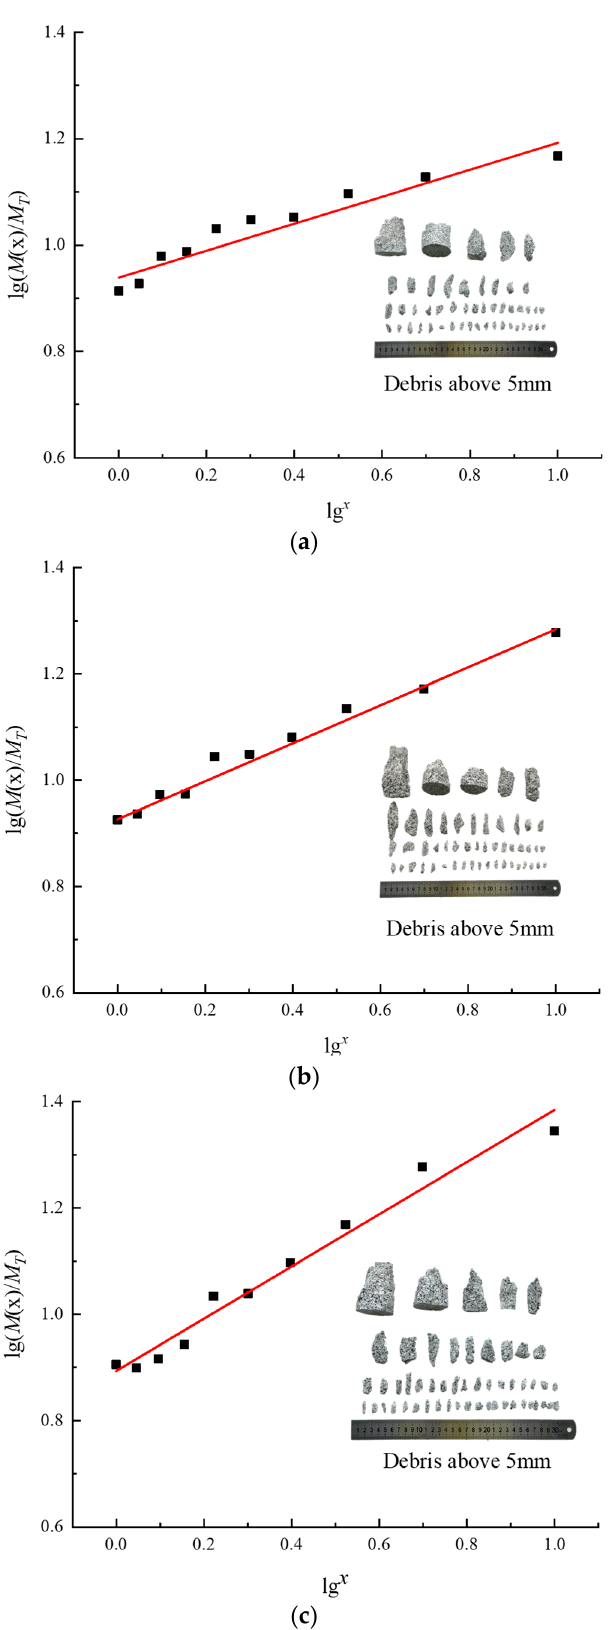
Figure 15. The log( M ( x )/ M T )–logx lines of rocks under 80% of the UCS: ( a ) 20 MPa; ( b ) 30 MPa; ( c ) 40 MPa.